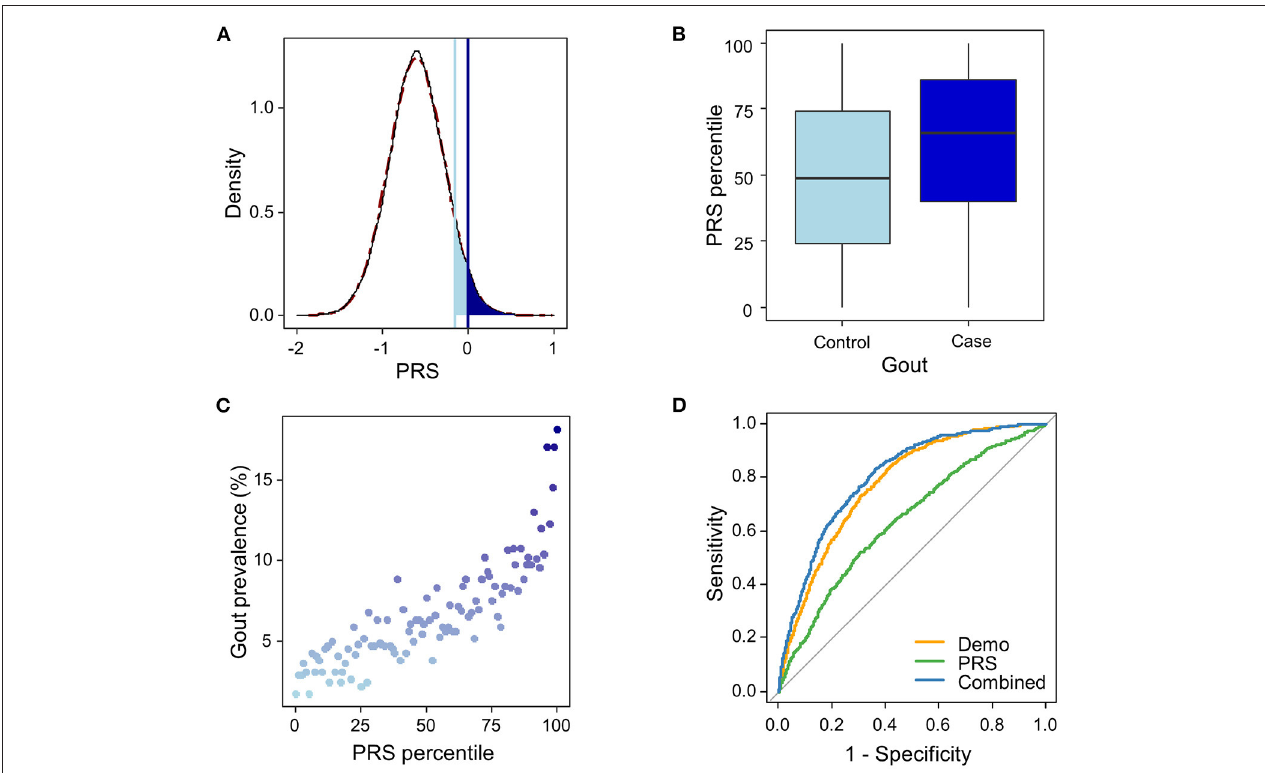
FIGURE 2 | Risk and prediction for gout by urate-polygenic risk score (PRS) derived in European ancestry. (A) Distribution of PRS ( n = 44,062). A theoretical normal distribution (dashed line in dark red) was overlaid on the PRS density plot. Shading reflects the proportion of the population with 2.5 (light blue) and 3-fold (dark blue) increased risk vs. the remainder of the population. The odds ratio was assessed in a logistic regression model adjusted for age, sex, BMI, and genotyping array. (B) PRS percentile among gout cases vs. controls. Within each boxplot, the horizontal lines reflect the median, the top and bottom of each box reflect the interquartile range, and the whiskers reflect the maximum and minimum values within each grouping. (C) Prevalence of gout in 100 groups binned according to the percentile of the PRS. (D) The ROC curves in the testing dataset from the three logistic regression models trained in the training dataset using PRS only (green line), demographic features (age, sex, and BMI; orange line), and the combined features (blue